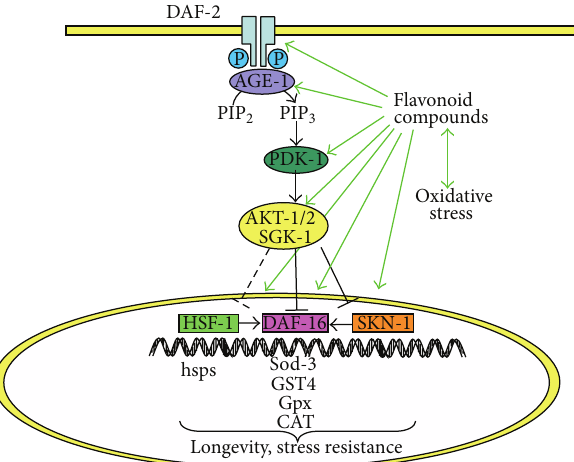
Figure 3: Simplified scheme of the DAF-16 signalling pathway in C. elegans representing molecular targets for modulation by